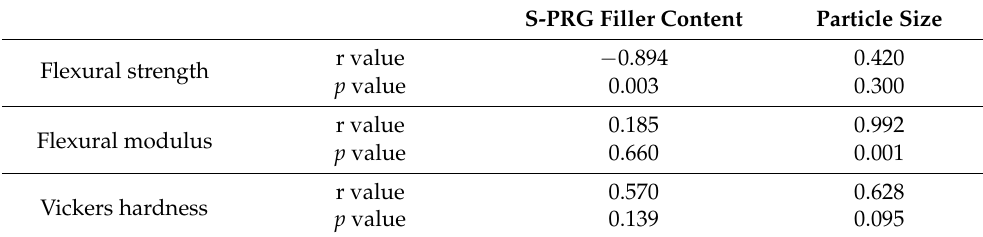
Table 3. Results of the Pearson correlation test between S-PRG filler content or particle size and mechanical properties using calculated coefficient r and p